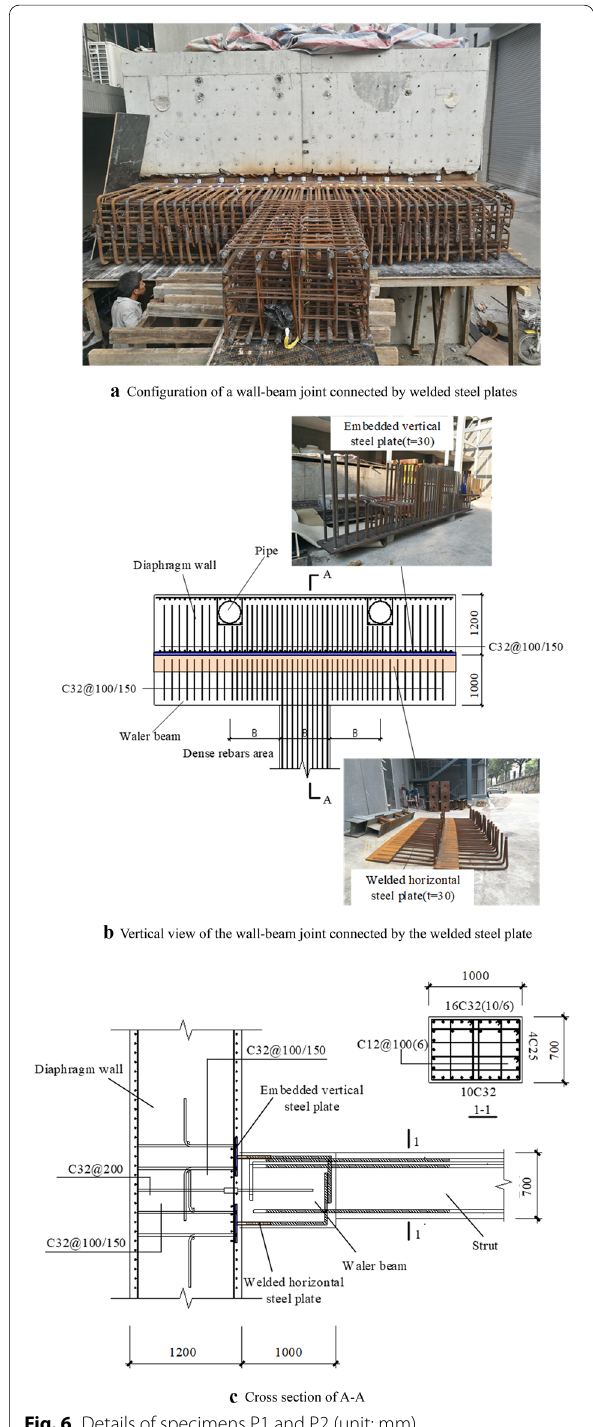
Fig. 6 Details of specimens P1 and P2 (unit: mm).